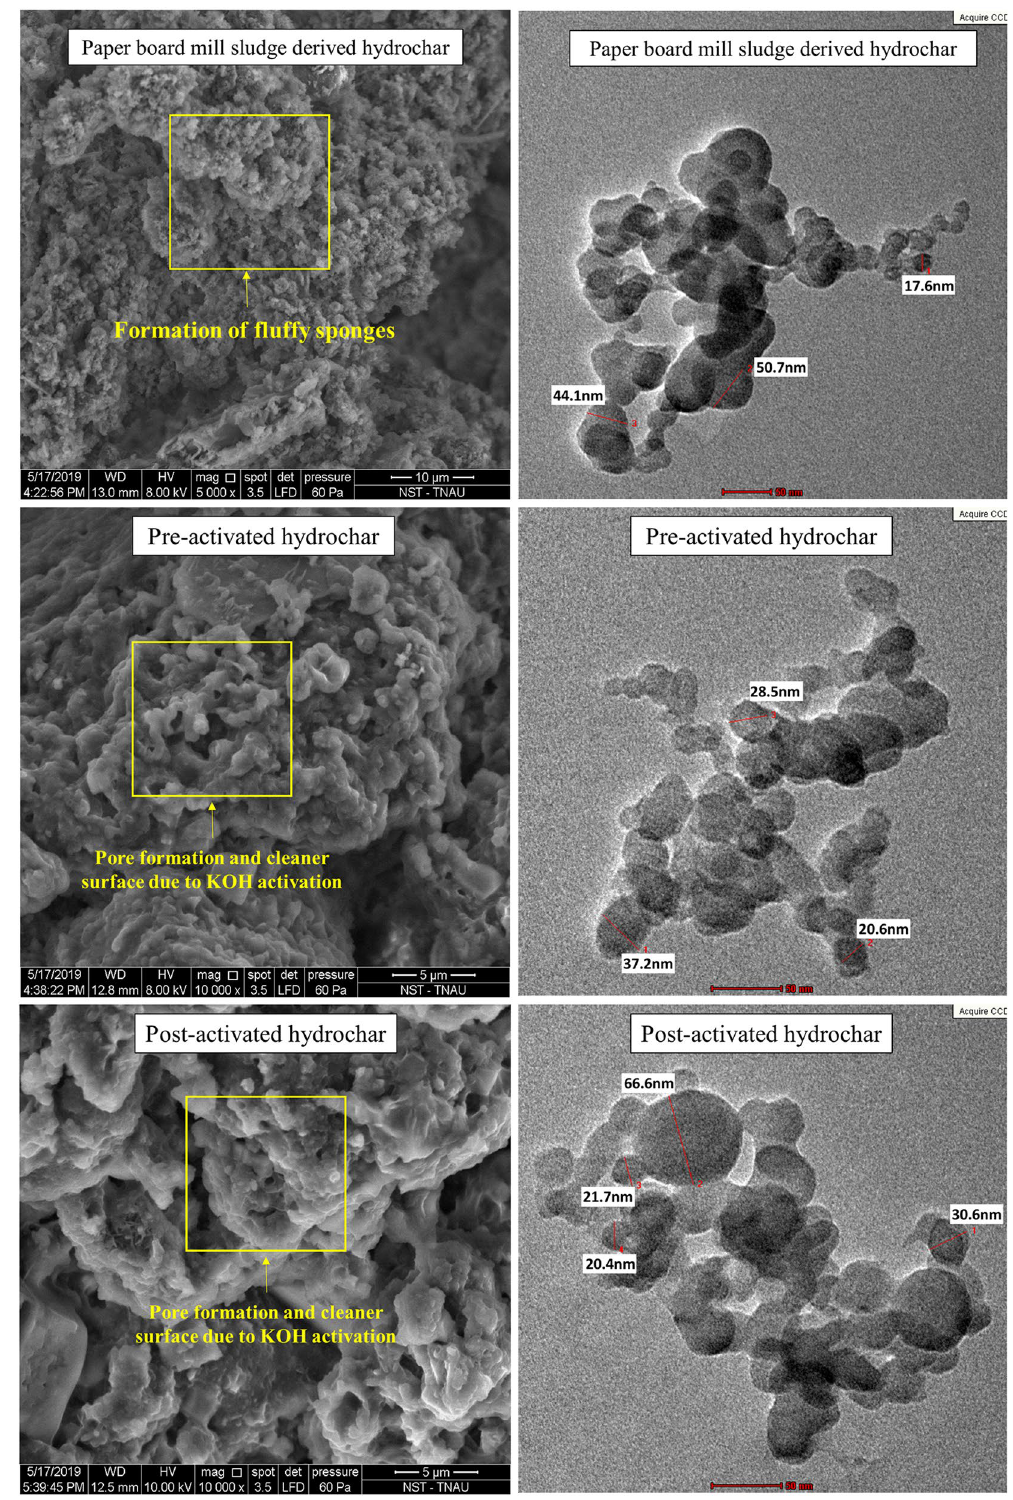
Figure 5. SEM and TEM micrographs of